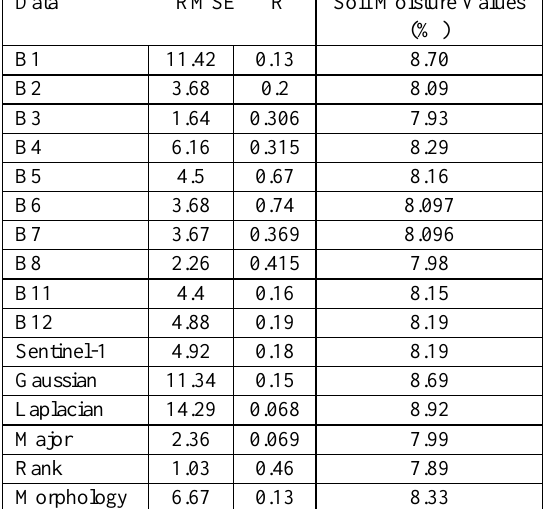
Table 3. Correlation and RMSE results between input data and soil